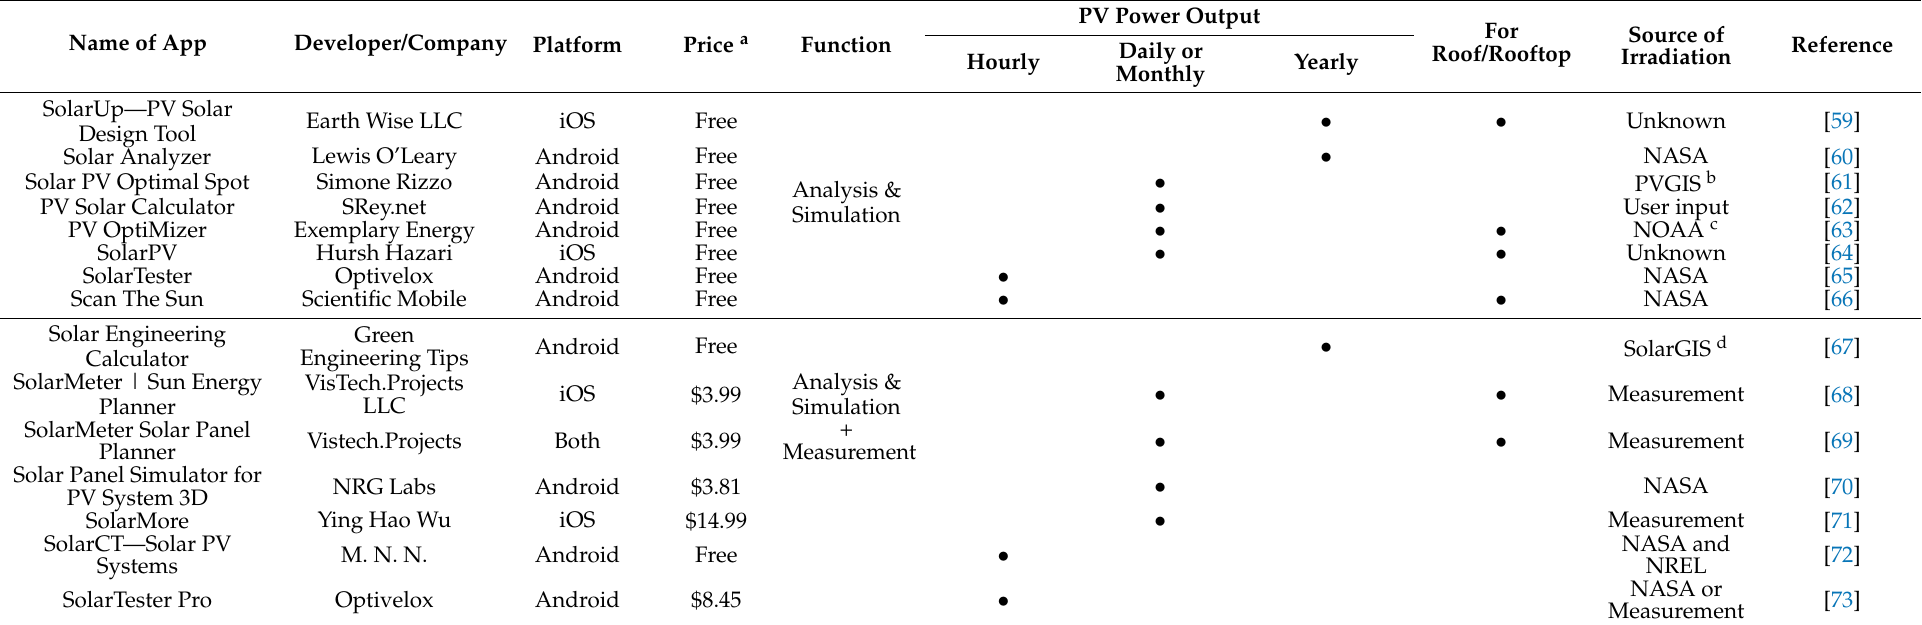
Table 6. Summary of smartphone applications for potential assessment of PV